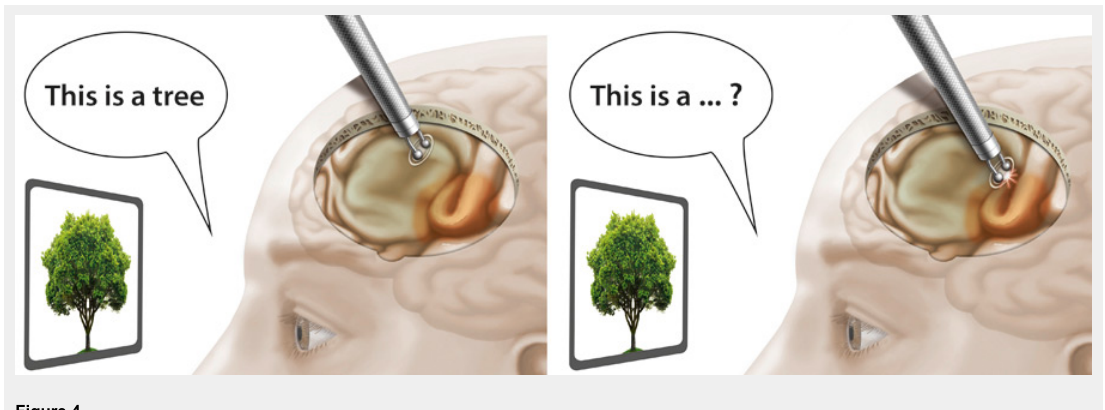
Figure 4 Speech mapping during awake craniotomy. Left: the patient correctly names items during electrical stimulation of non-eloquent areas and tumour tissue. Right: speech anomalies during stimulation reveal eloquent areas (brown) that need to be spared to avoid postoperative speech